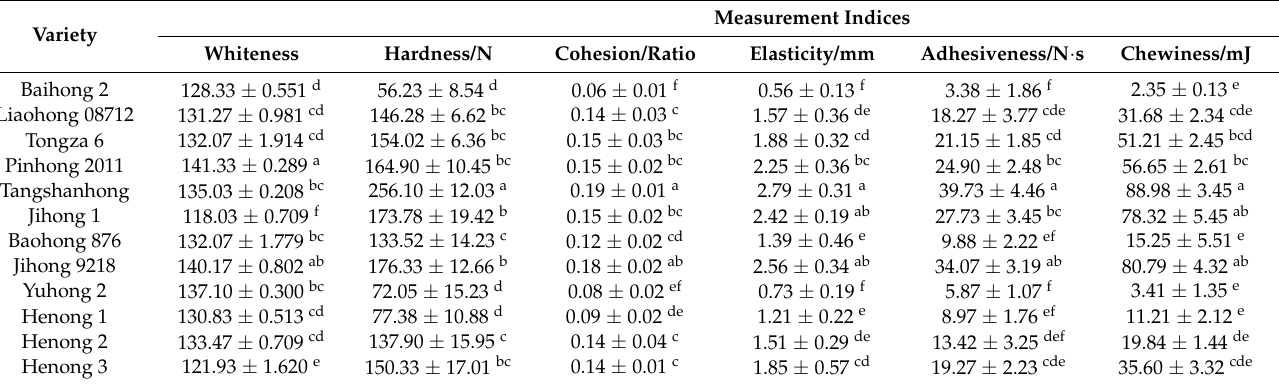
Table 2. Crude starch whiteness and texture characteristics of different adzuki bean